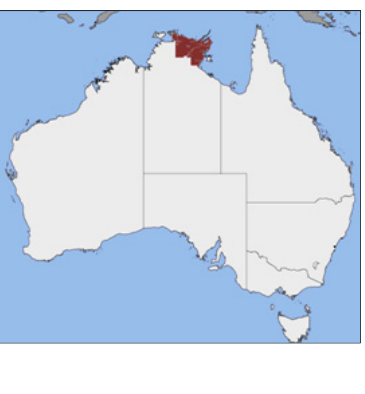
Figure 2. Location of Arnhem Land, Northern Territory, Australia (area shaded in